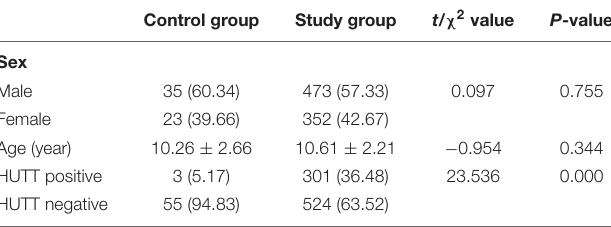
TABLE 1 | Clinical characteristics and HUTT positive rate of the study and control groups [ n = 883, mean ± SD, n (%)]. Control group